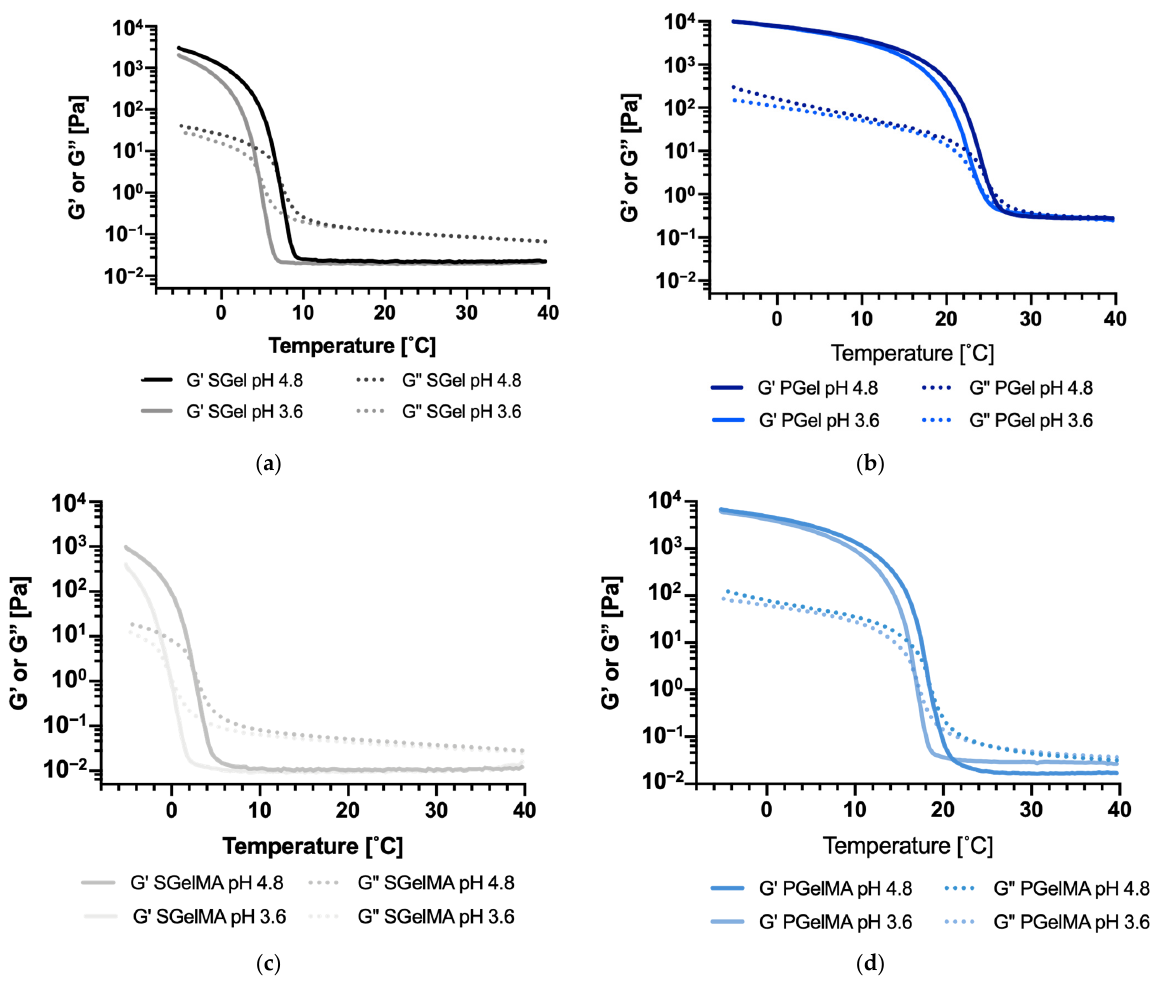
Figure 5. Storage (G ′ ) and loss modulus (G ″ ) for gelatin and GelMA suspensions (10% w / v ) at pH ~3.6 and ~4.8 at di ff erent temperatures (cooling ramp from 40 to − 5 °C). ( a ) SGel, ( b ) PGel, ( c ) SGelMA, ( d ) PGelMA. Table 3. Gelation temperature (Tgel) of di ff erent gelatin suspensions (10% w / v ) determined by rhe- ology, and di ff erences in Tgel due to di ff erences in pH ( ∆ Tgel). Values are presented as average ± standard deviation.